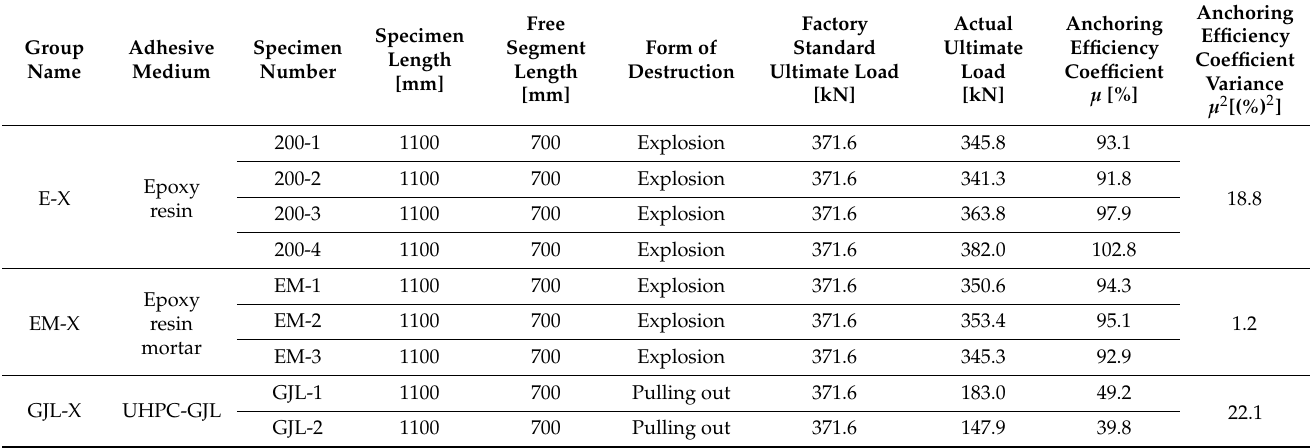
Table 5. Statistical results of the failure modes of the specimens in the control group with the bonding